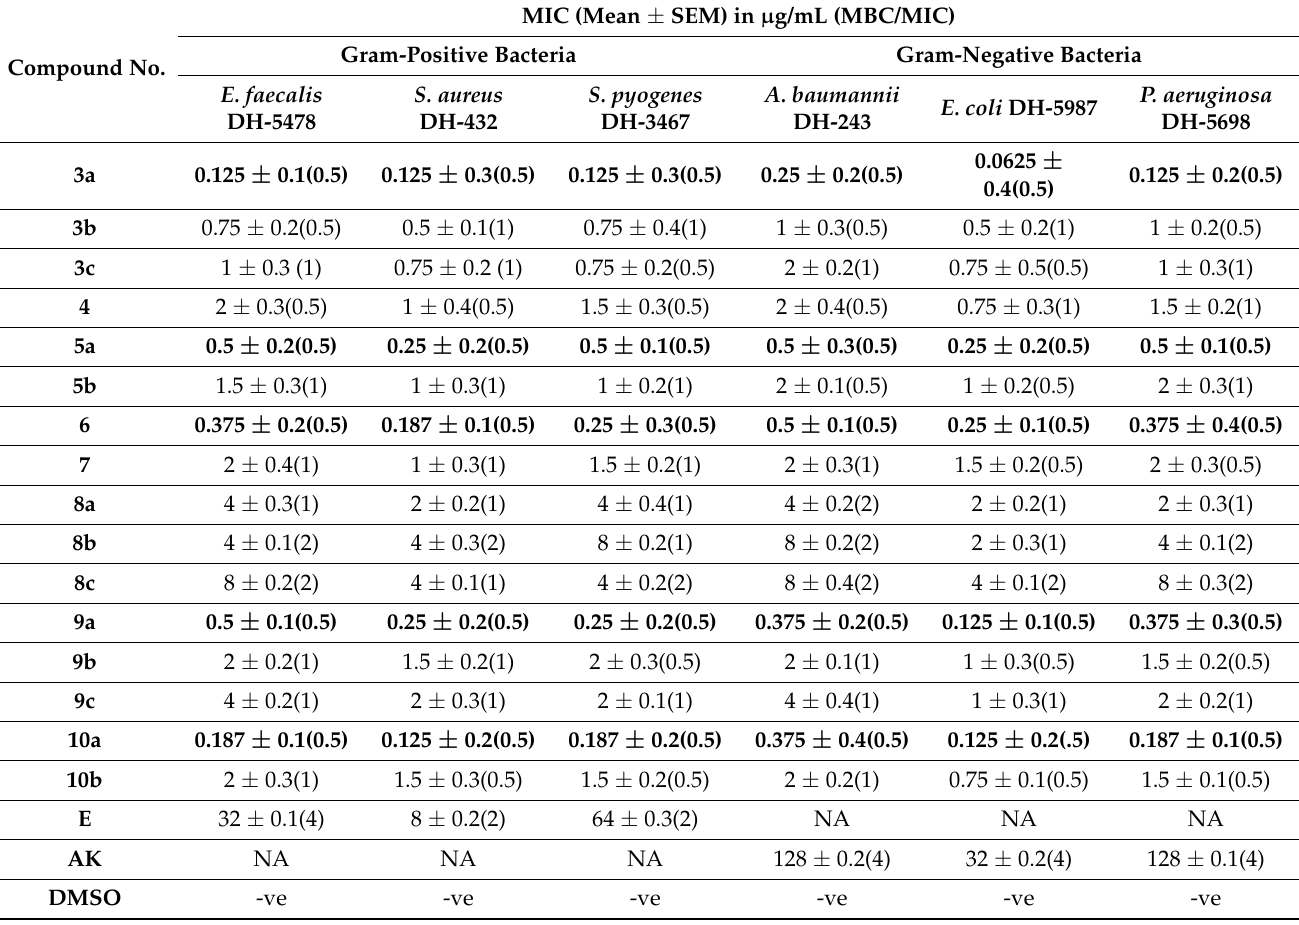
Table 2. In vitro antibacterial activity for the most active pyrazole and pyrazolo[1,5- a ]pyrimidine derivatives 3 – 10 represented as MIC in µ g/mL and